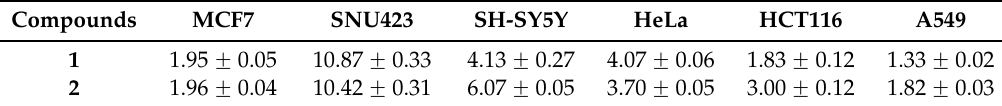
Table 2. IC 50 values ( µ M) of compounds 1 and 2 against human cancer cell lines. Compounds MCF7